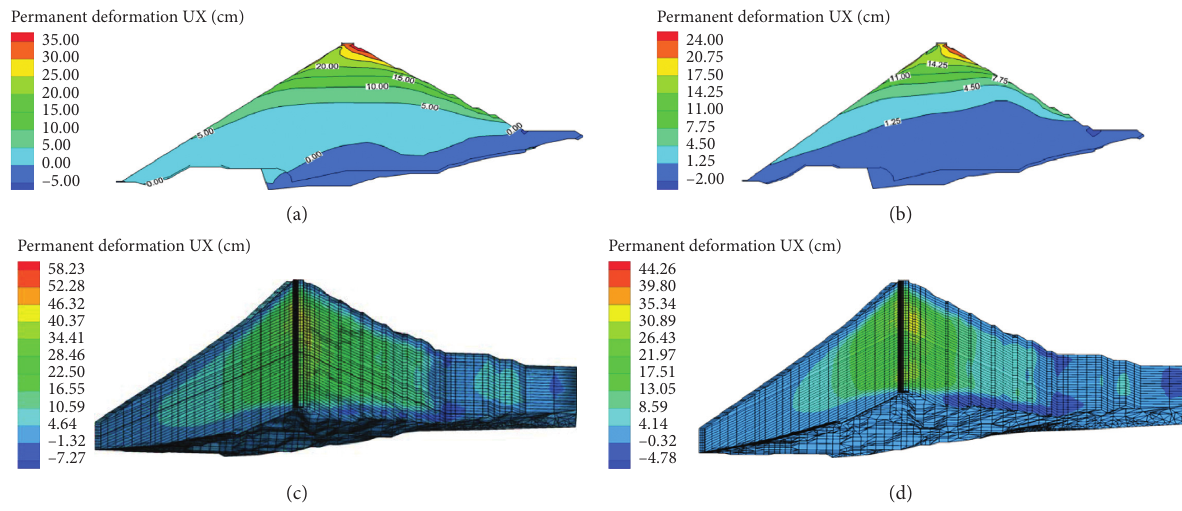
Figure 7: Permanent deformation in the up-downstream direction (cm). (a) A 2D view image of the distribution of permanent deformation based on UHS. (b) A 2D view image of the distribution of permanent deformation based on site-related response spectrum using scenario earthquake (SRRS). (c) A 3D view image of the distribution of permanent deformation based on UHS. (d) A 3D view image of the distribution of permanent deformation based on site-related response spectrum using scenario earthquake (SRRS).